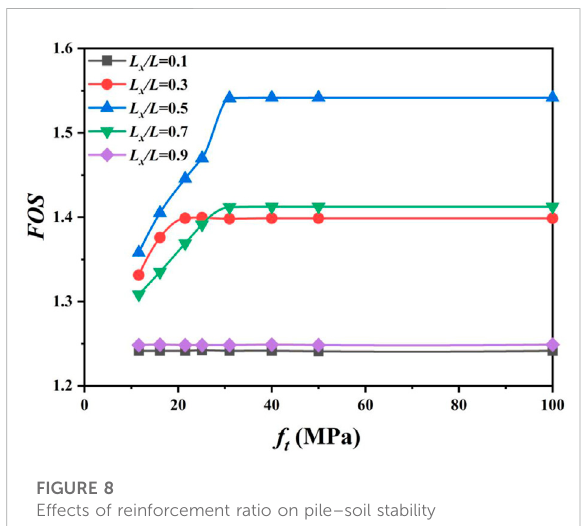
FIGURE 8 Effects of reinforcement ratio on pile – soil stability considering damage constitutive